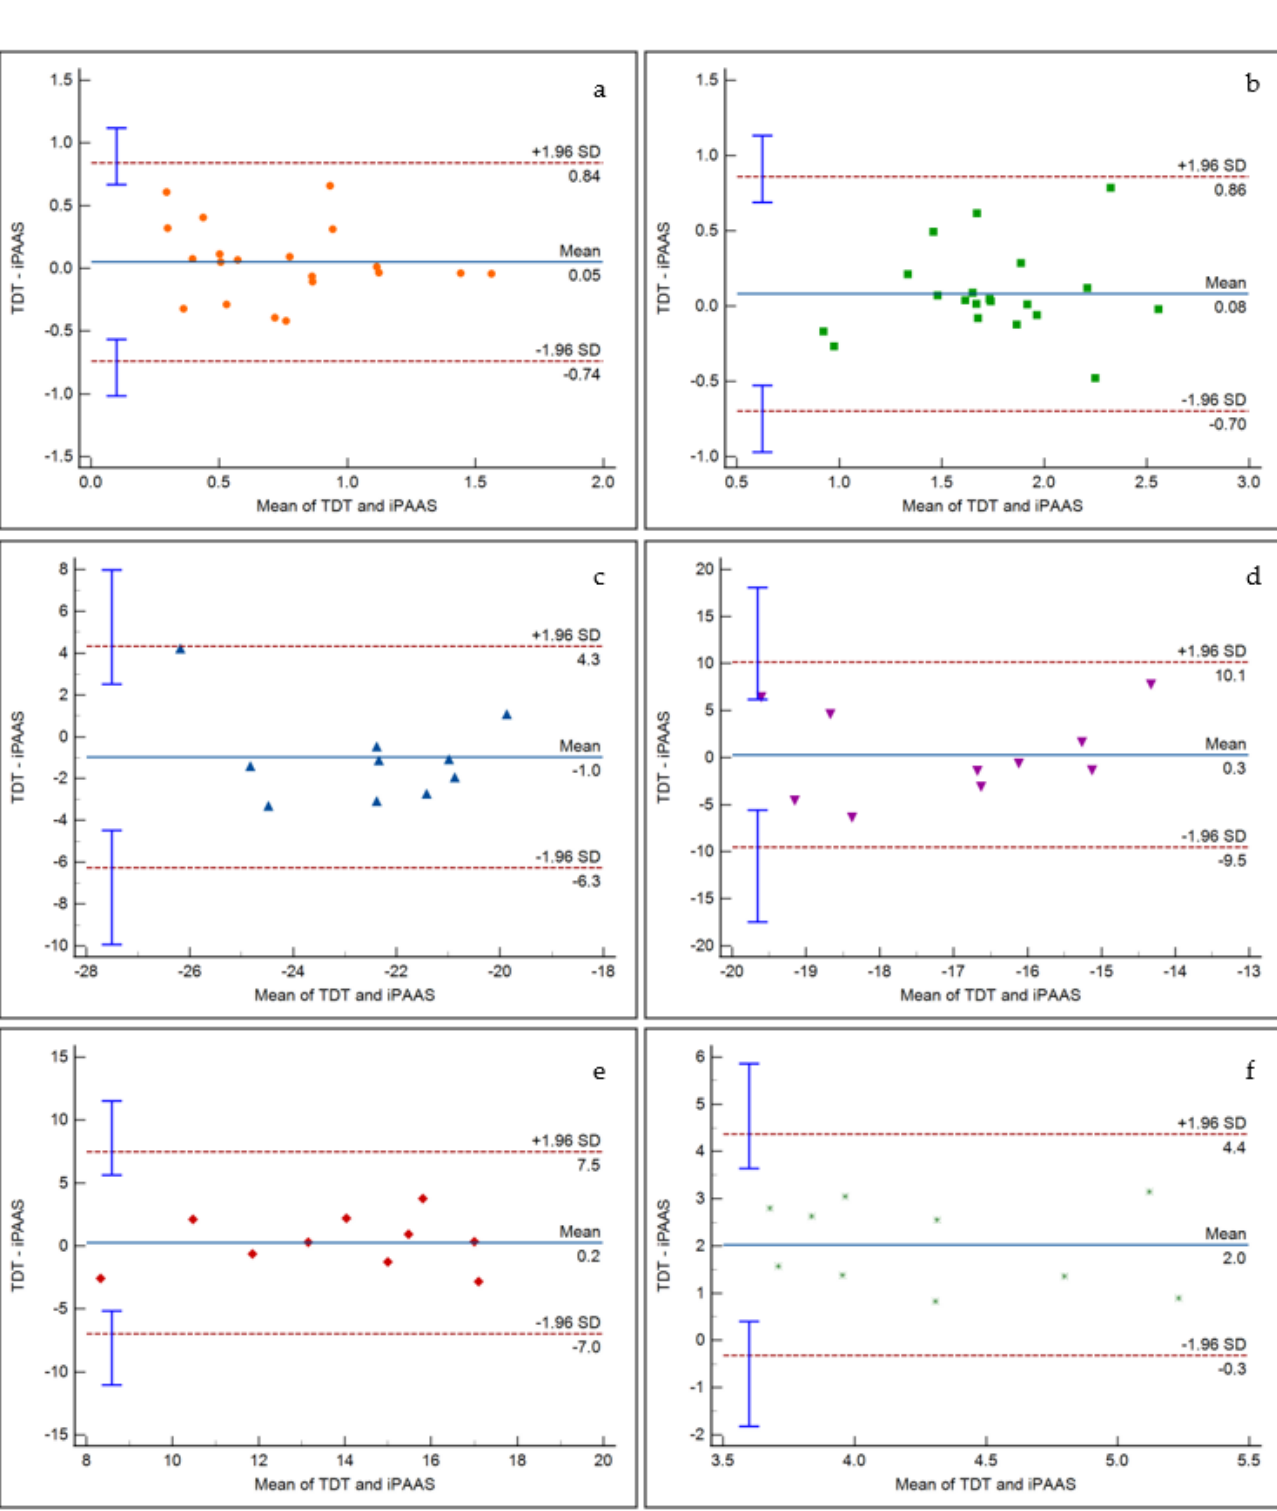
Figure 7. Bland Altman analysis results for ( a ) frequency discrimination at 500 Hz, ( b ) frequency discrimination at 4000 Hz, ( c ) AM detection at 20 Hz modulation frequency, ( d ) AM detection at 200 Hz modulation frequency, ( e ) BMLD at 500 Hz, and ( f ) gap detection. The x axis represents the mean of corresponding TDT and iPAAS thresholds, while the y axis represents their difference. The dashed lines represent the limits of agreements, while the blue error bars represent the corresponding 95% confidence intervals.